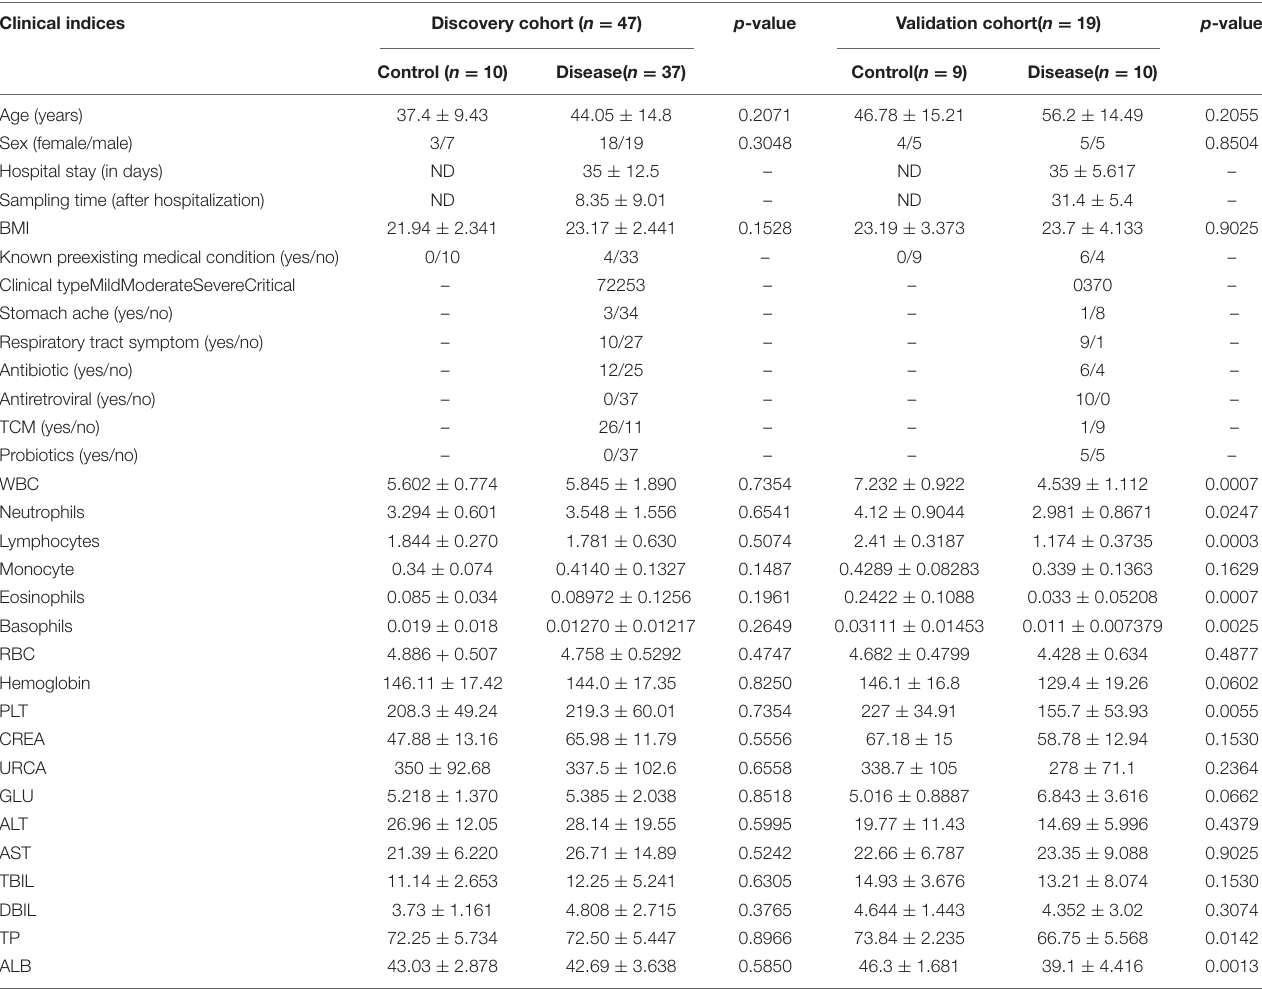
TABLE 1 | The clinical characteristics of the participants in the discovery and validation cohort. Clinical